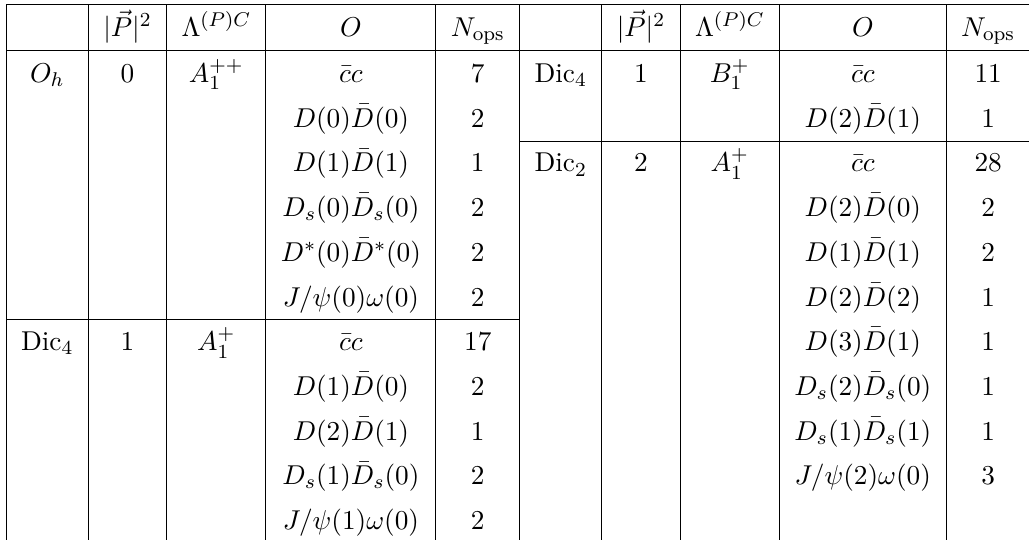
Table 2 . The single- and two-meson interpolators utilized in each lattice irrep Λ ( P ) C considered in this study. We use the simplified notation M 1 ( ~p 2 the momentum ~p i of each meson ( i = 1 , 2 ) given in units of 2 π/L . The full expressions are omitted for brevity. N ops indicates the number of operators of each type